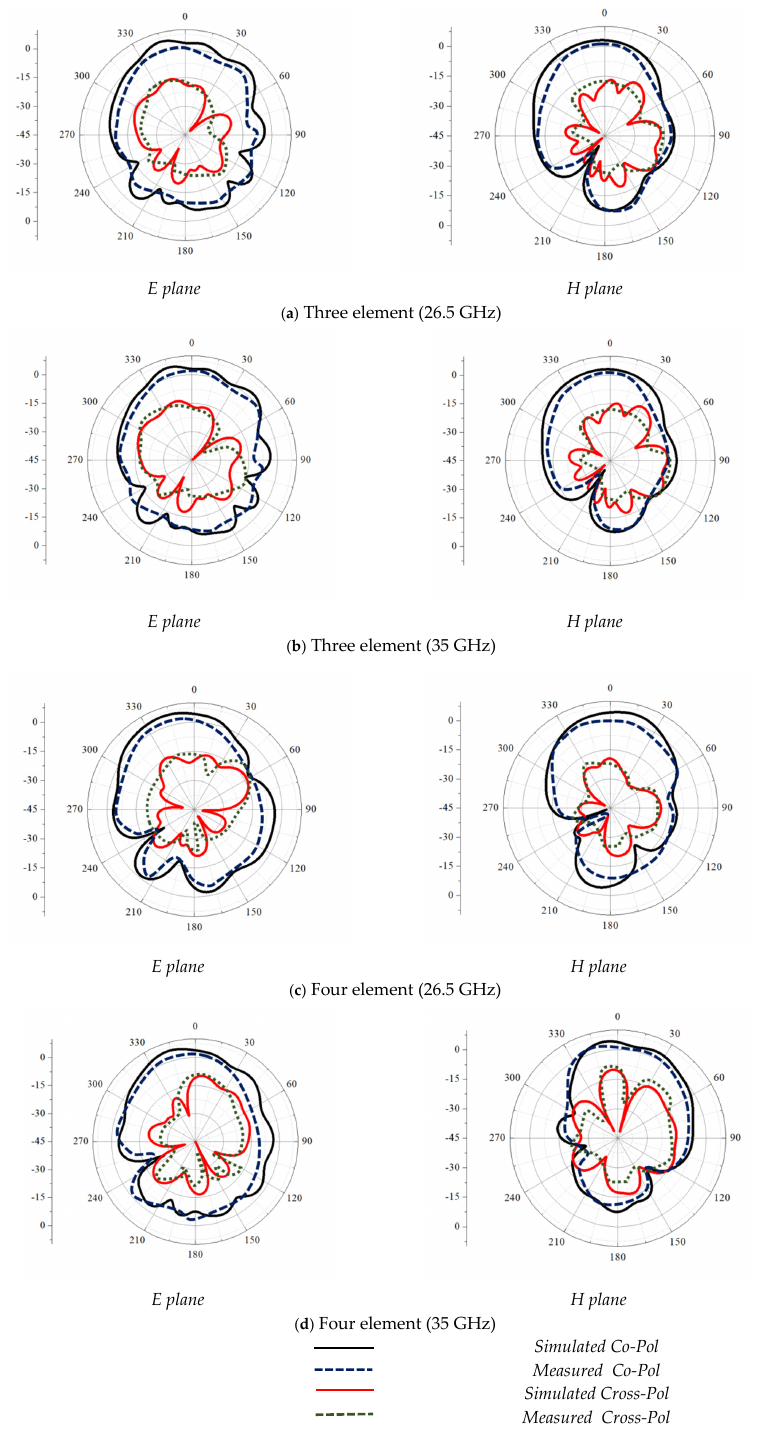
Figure 17. Simulated and measured co-pol and cross-pol patterns of the antenna.